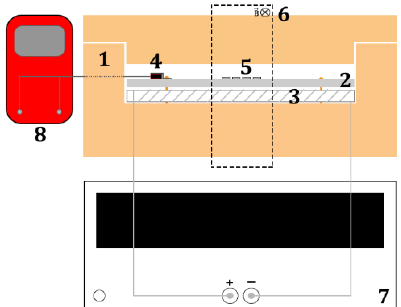
Figure 1. Schematic view of the magnetoelectric (ME) gradient structure.